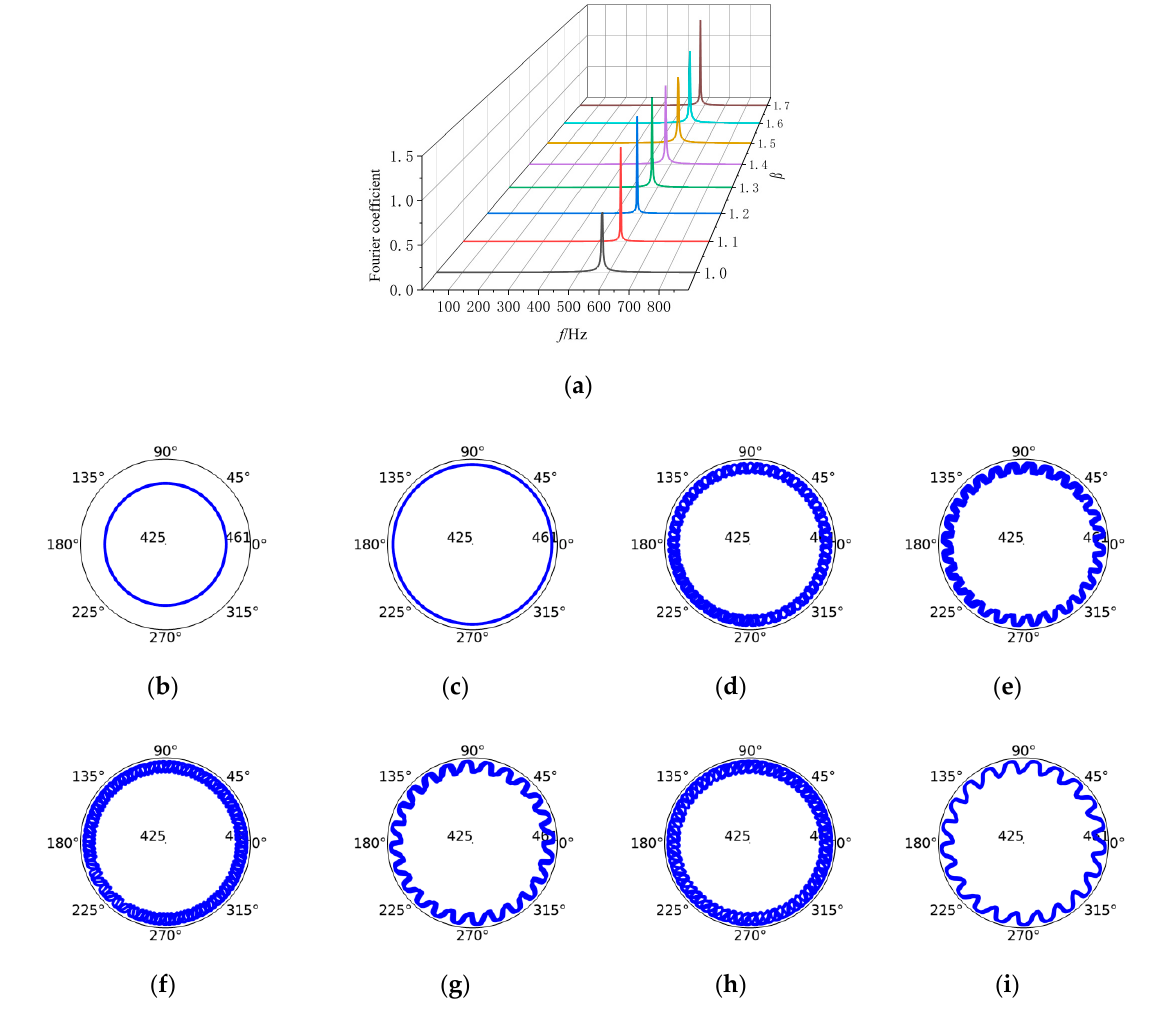
Figure 10. Frequency spectrum and circumferential wear shape under difference speed: ( a ) frequency spectrum; circumferential wear shape at ( b ) β = 0.2 ( V = 36 km/h); ( c ) β = 1.8 ( V = 324 km/h); ( d ) β = 1.1 ( V = 198 km/h); ( e ) β = 1.2 ( V = 216 km/h); ( f ) β = 1.3 ( V = 234 km/h); ( g ) β = 1.4 ( V = 252 km/h); ( h ) β = 1.5 ( V = 270 km/h); ( i ) β = 1.6 ( V = 288 km/h).